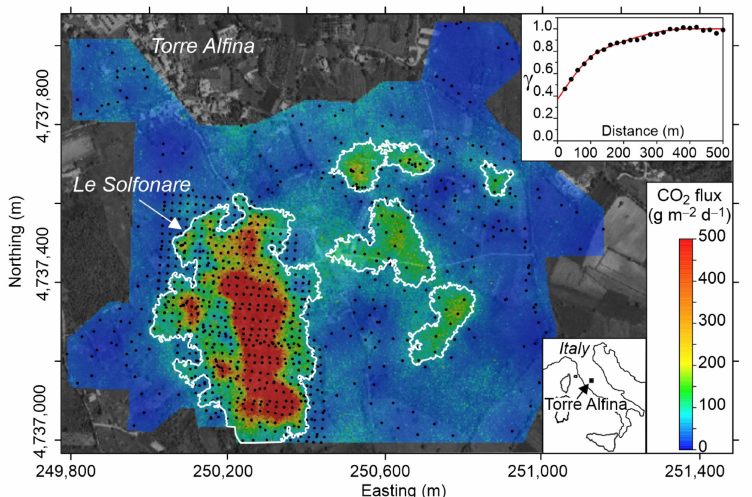
Figure 4. Map of the CO 2 diffuse degassing from Torre Alfina obtained through 200 sGs simulations. In the figure are reported the measurement points (dots); the experimental variogram and the variogram model (red curve) used in the sGs (upper right inset); and the contour of the Torre Alfina DDS (white line) defined as the area where over 50% of the 200 simulated CO 2 flux values are higher than the biogenic CO 2 flux threshold (35 g m − 2 d − 1 , see the text). Coordinates refer to WGS 84/UTM zone 33